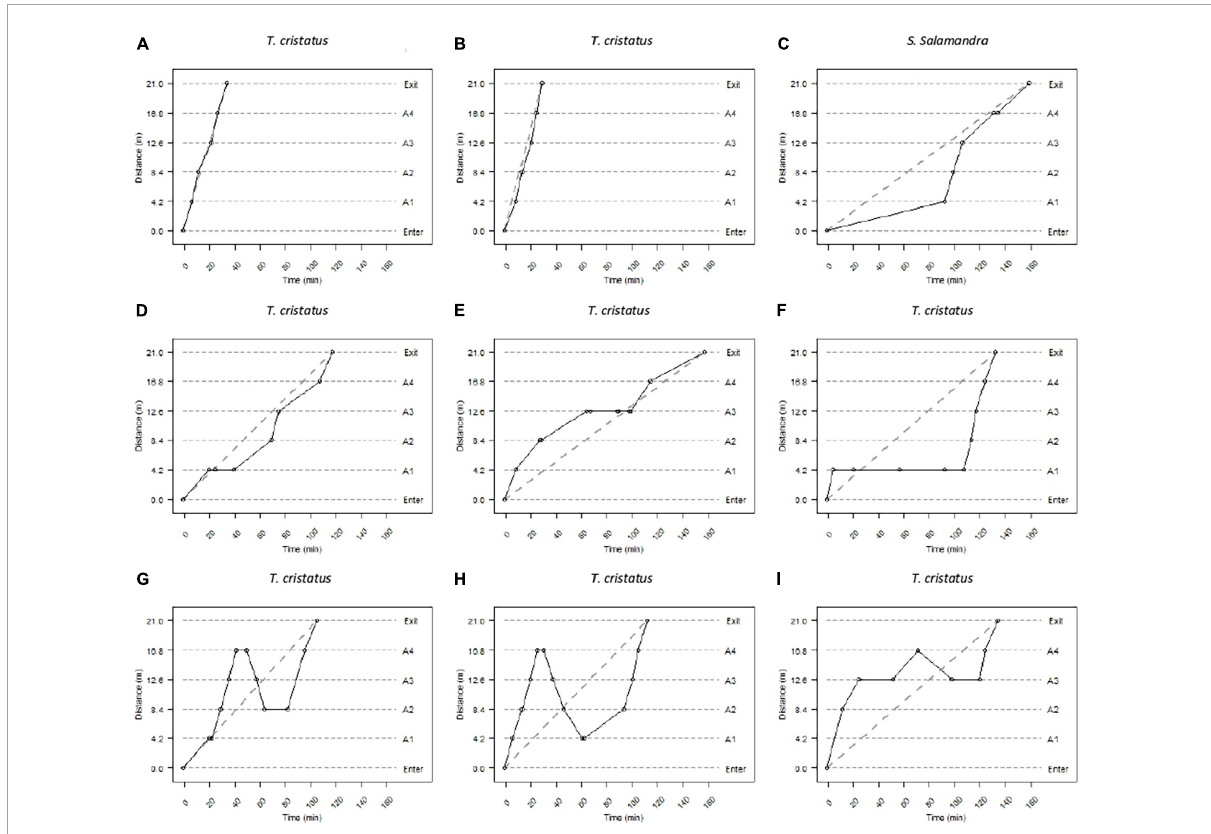
FIGURE3 Different types of movement exhibited during a complete crossing. The dashed lines represent the entry, exit, and location of the antennas in the tunnels. The positions of the individuals in the tunnels at the time since release are represented by dots. The solid lines represent the speed of movement between the different positions. Panels (A–I) represent several patterns of movement (see section